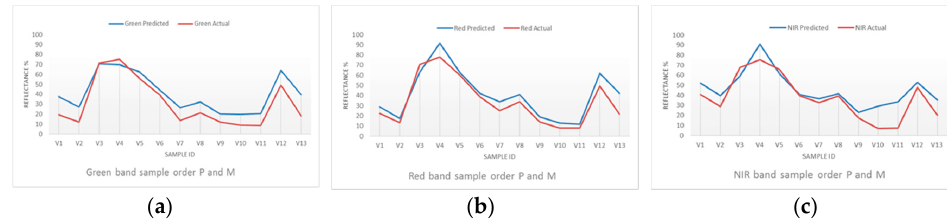
Figure 9. M (red line) and P reflectance plots for G ( a ); R ( b ) and NIR ( c ) bands from EL2 Dulux